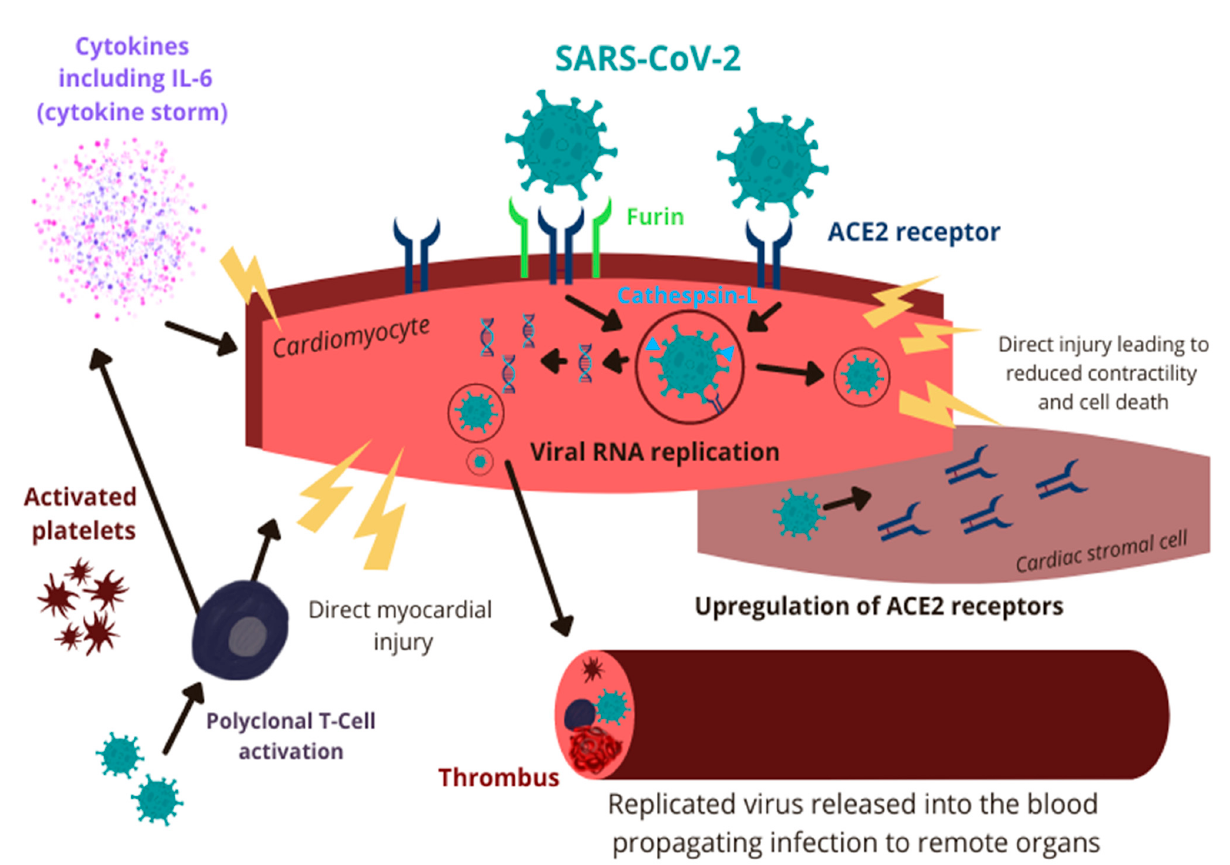
Figure 1. Pathophysiology of COVID-19-associated myocarditis. SARS-CoV-2: severe acute respir- atory syndrome coronavirus 2; IL-6: interleukin-6; ACE2: angiotensin-converting enzyme 2; RNA: ribonucleic acid.